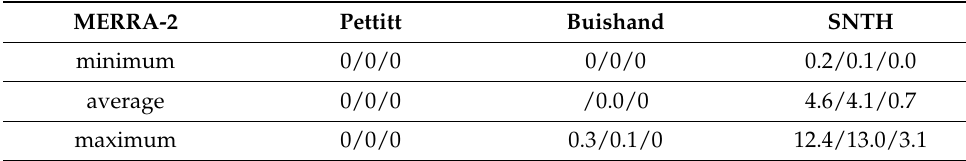
Table 4. The same as Table 3, but for